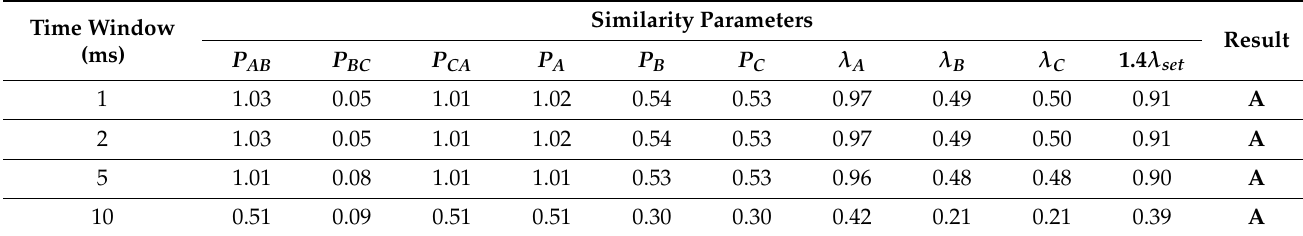
Table 9. Similarity parameters and faulty phase selection results under the influence of the sampling time window. Time Window